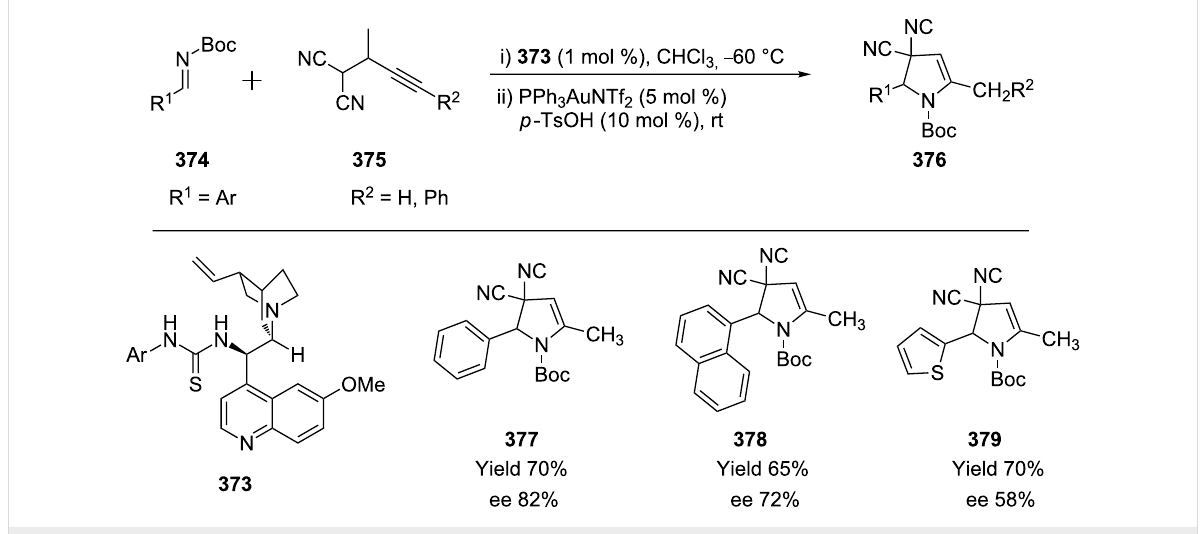
Scheme 60: Gold-catalyzed asymmetric synthesis of 2,3-dihydropyrroles.